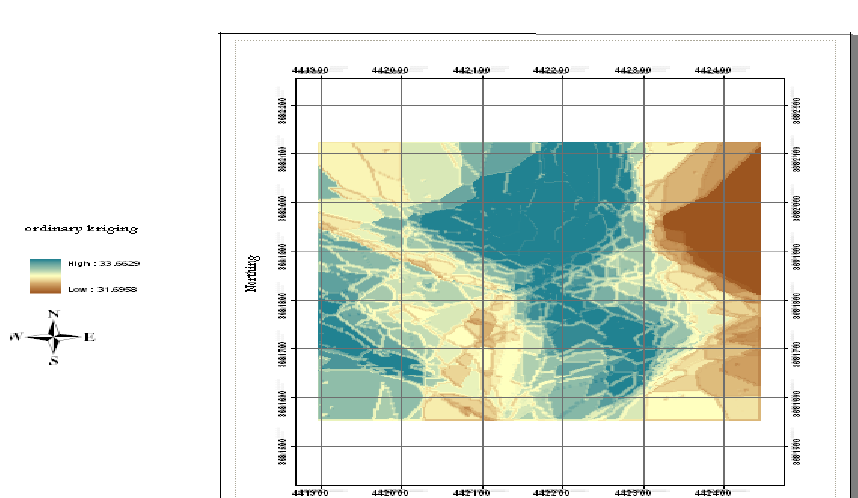
Fig. 5: The raster DEM of the ground level slice, using the IDW.